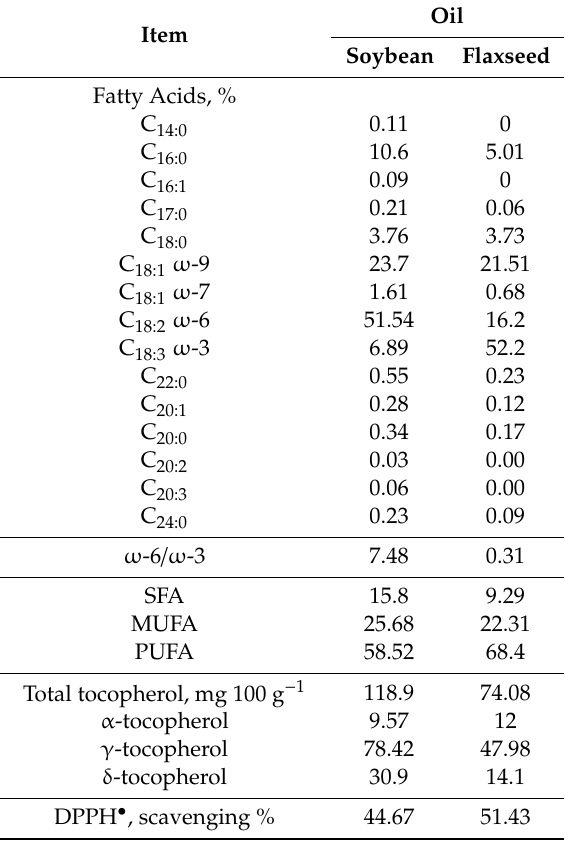
Table 1. Chemical composition of